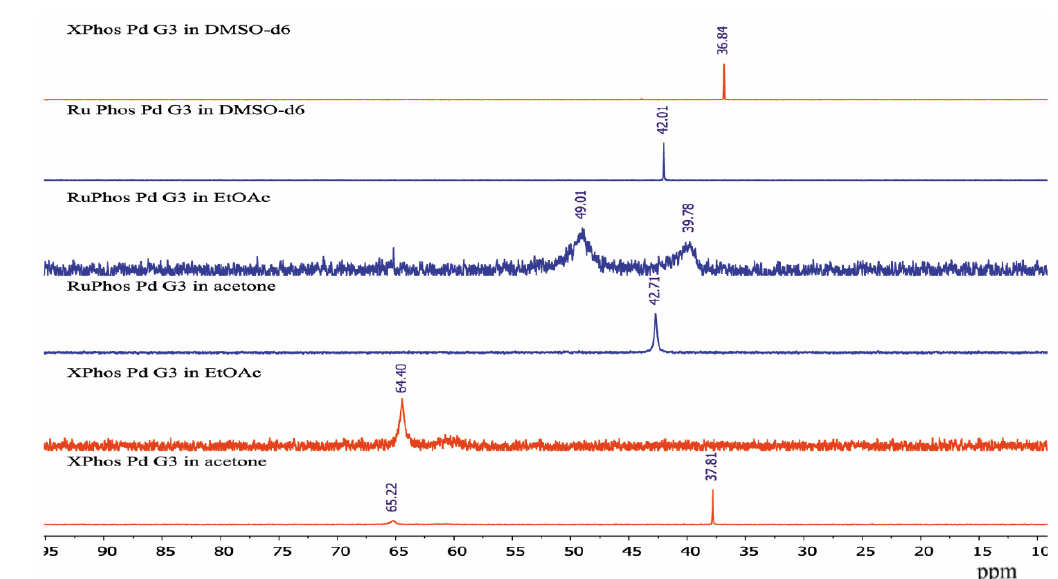
Figure 9. The 31 P-NMR spectra of XPhos Pd G3 and RuPhos Pd G3 in acetone, ethyl acetate solution and DMSO- d 6 solutions.